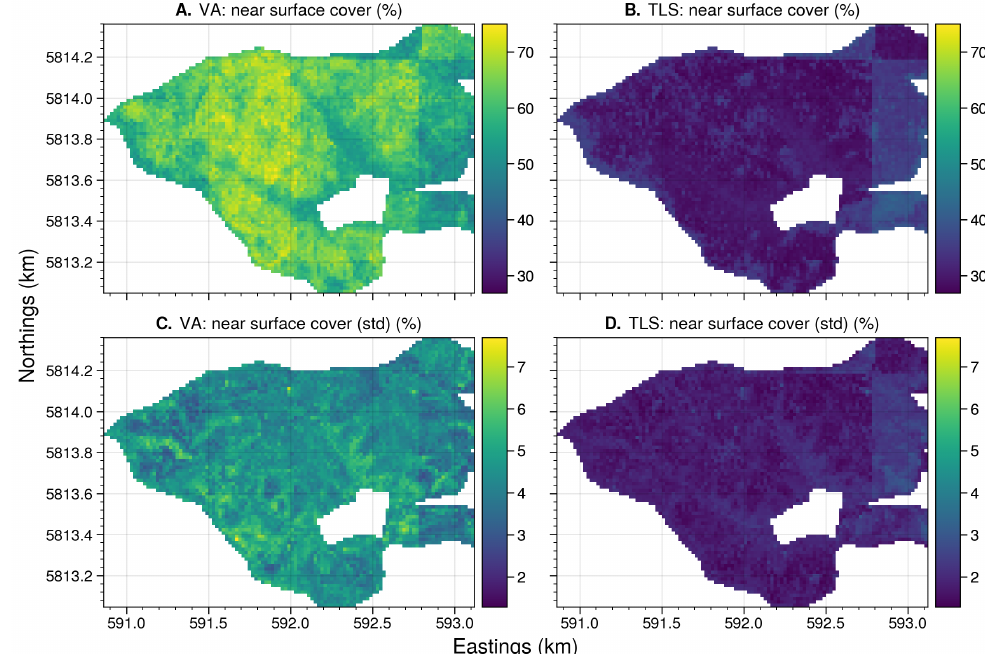
Figure A7. The mean and standard deviation of landscape-level predictions for near-surface fuel cover using visual assessments ( A , C ) and TLS ( B , D ) at Toorloo Arm.